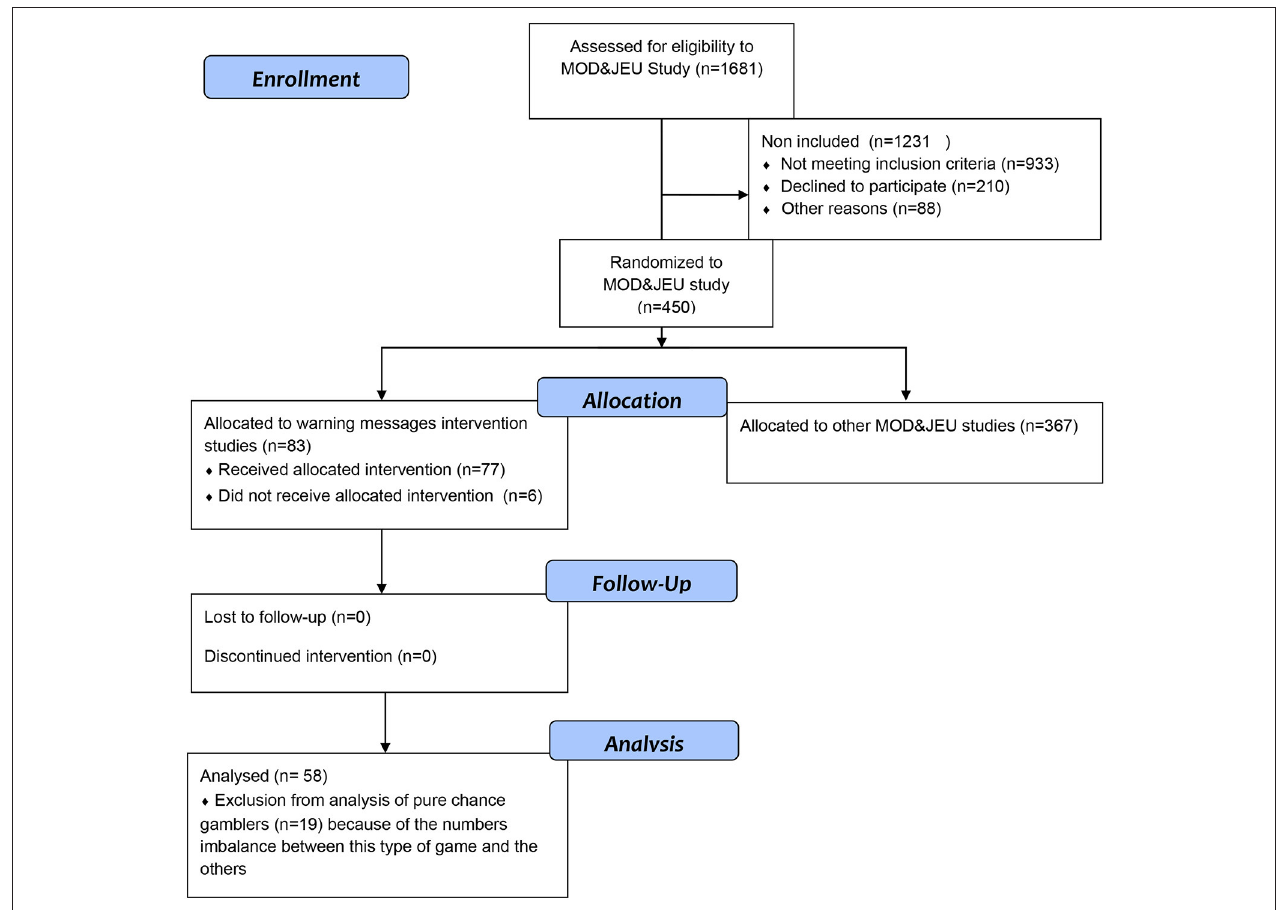
FIGURE 1 | Flowchart of